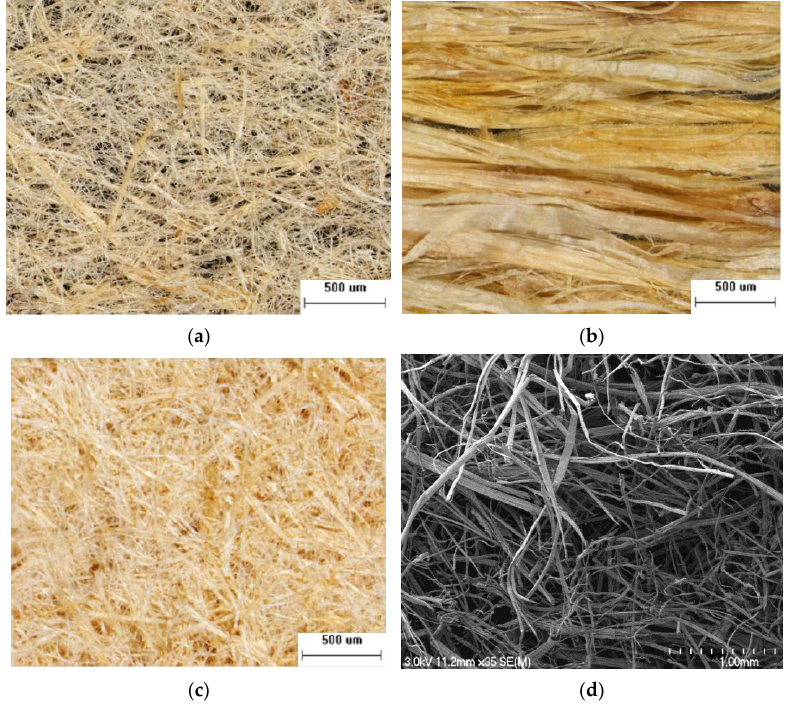
Figure 2. ( a – c ) Optical microscopic images of fibre mats produced using dynamic sheet forming (DSF), highly aligned sample and random mat, respectively, ( d ) scanning electron microscopic im- ages of fibre mats produced using DSF.